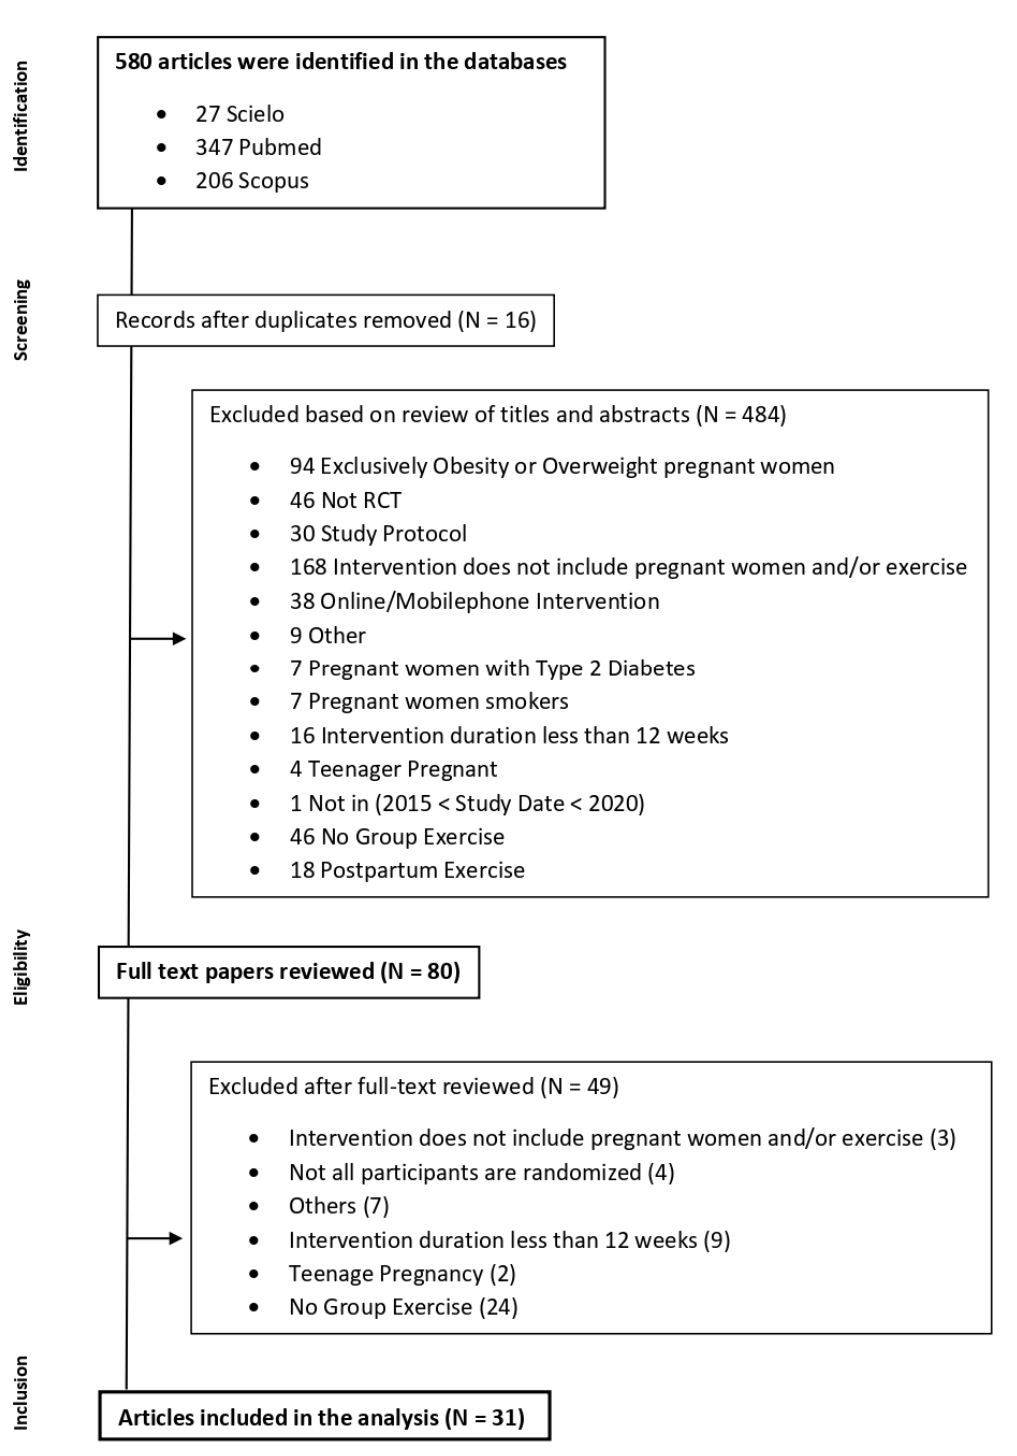
Figure 1. Flow diagram of literature search for group exercise interventions in pregnancy.